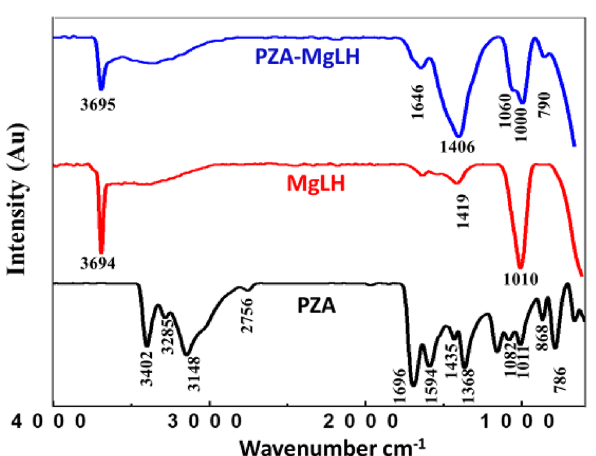
Figure 2. FTIR spectra of free pyrazinamide (PZA), magnesium layered hydroxides (MgLH) and the PZA- MgLH nanocomposite. AU = arbitrary